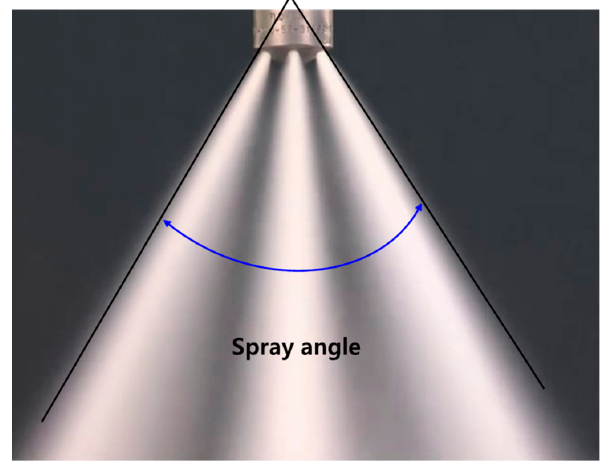
Figure 4. The definition of spray angle for the multihole urea nozzle used. Table 2. Experimental conditions for the nozzle and mixer, and reactor configurations.